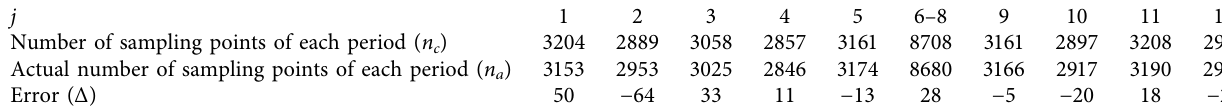
Table 3: Error of cylinder knock fault signal period.